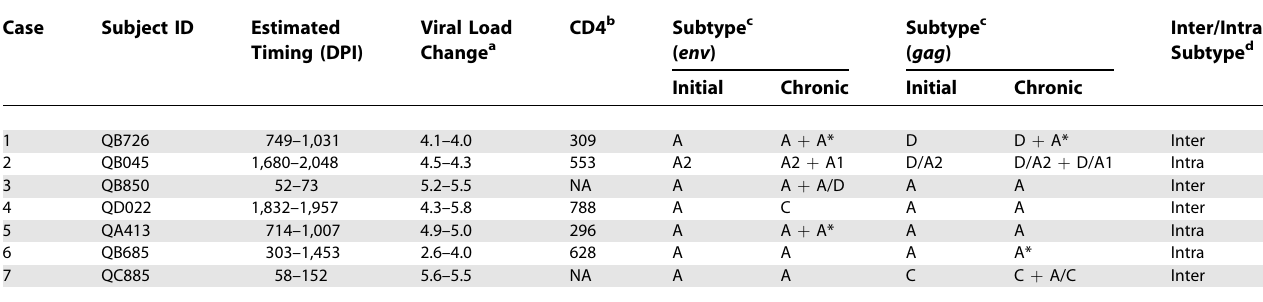
Table 1. Summary and Estimated Timing of HIV-1 Superinfection